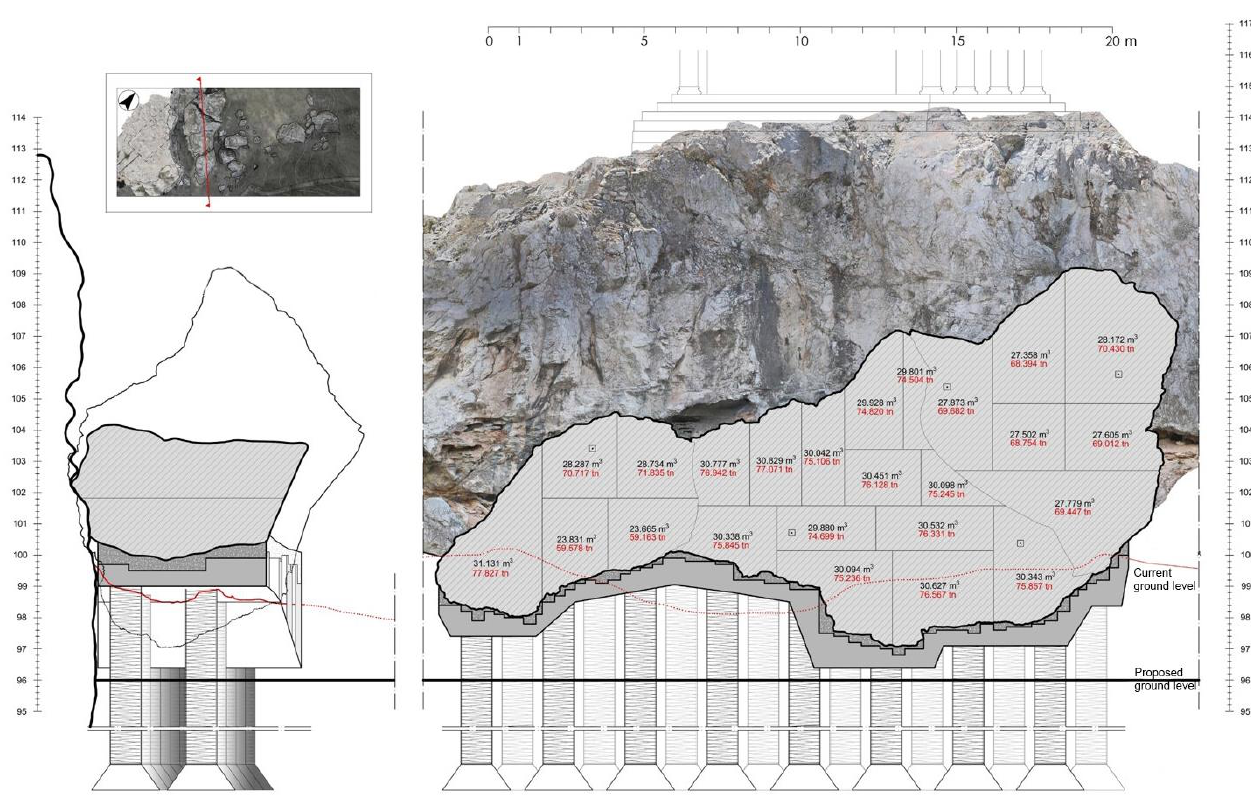
Figure 13: Segments from rocks 1A, 1B & 1C placed on top of concrete